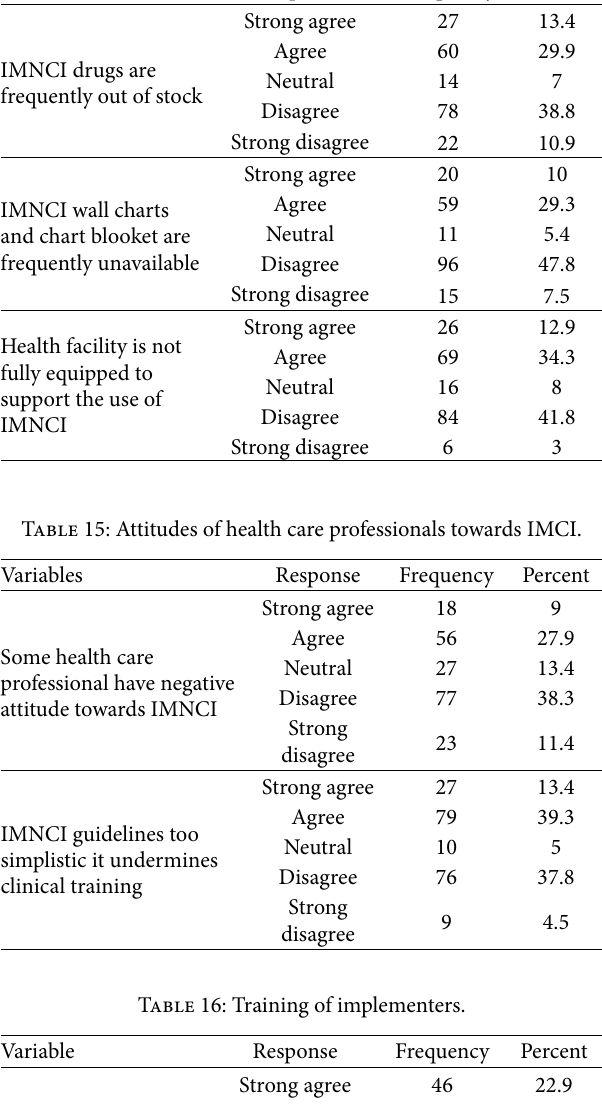
Table 12: Experiences of the health care providers in implementing the guidelines and procedures of the IMCI strategy.